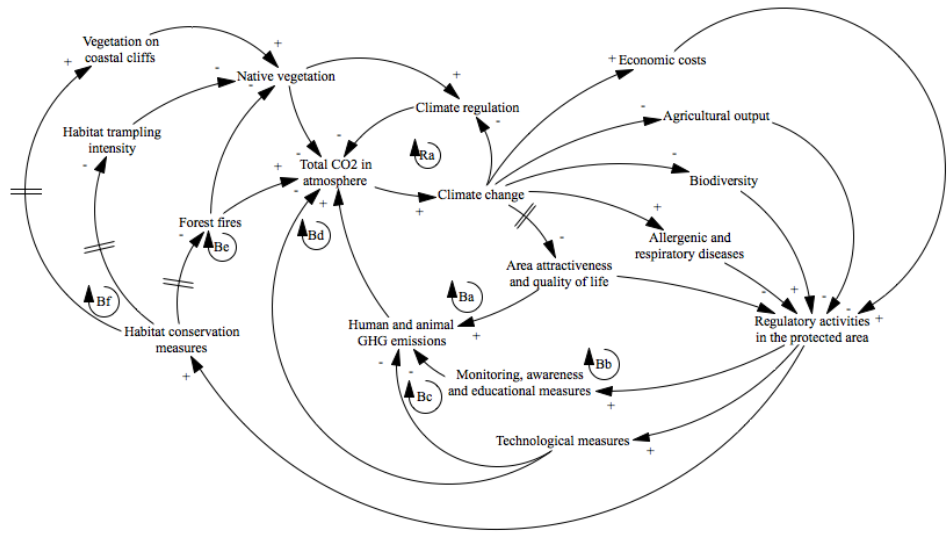
Fig. 4. Climate regulation causal loop